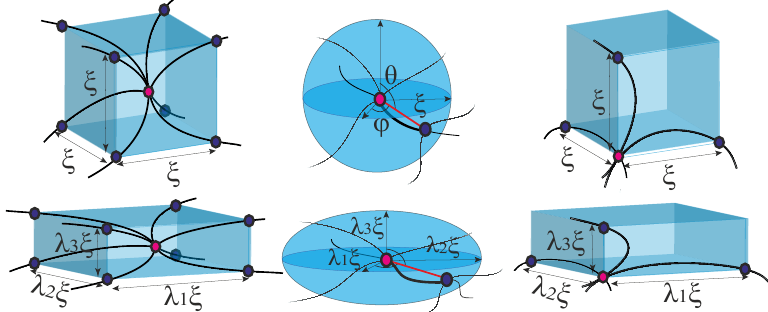
Figure 7. Cells in a semiflexible network before and after deformations for body-centred cubic lattice of 8-chain model, the homogeneous sphere in 1-chain model, and primitive cubic lattice of 3-chain